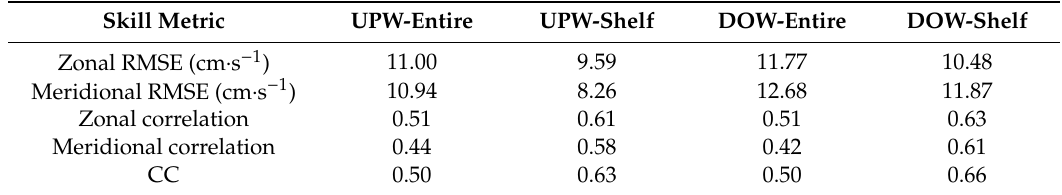
Table 4. Overview of skill metrics derived from IBI–HFR comparison of surface currents for the selected UPW and DOW events, spatially averaged over the entire common domain (Entire) and exclusively over the Galician continental shelf